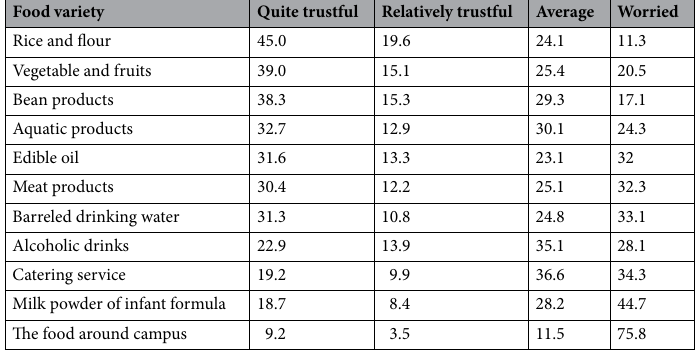
Table 3. Degrees of trust of residents in food safety Unit: %.